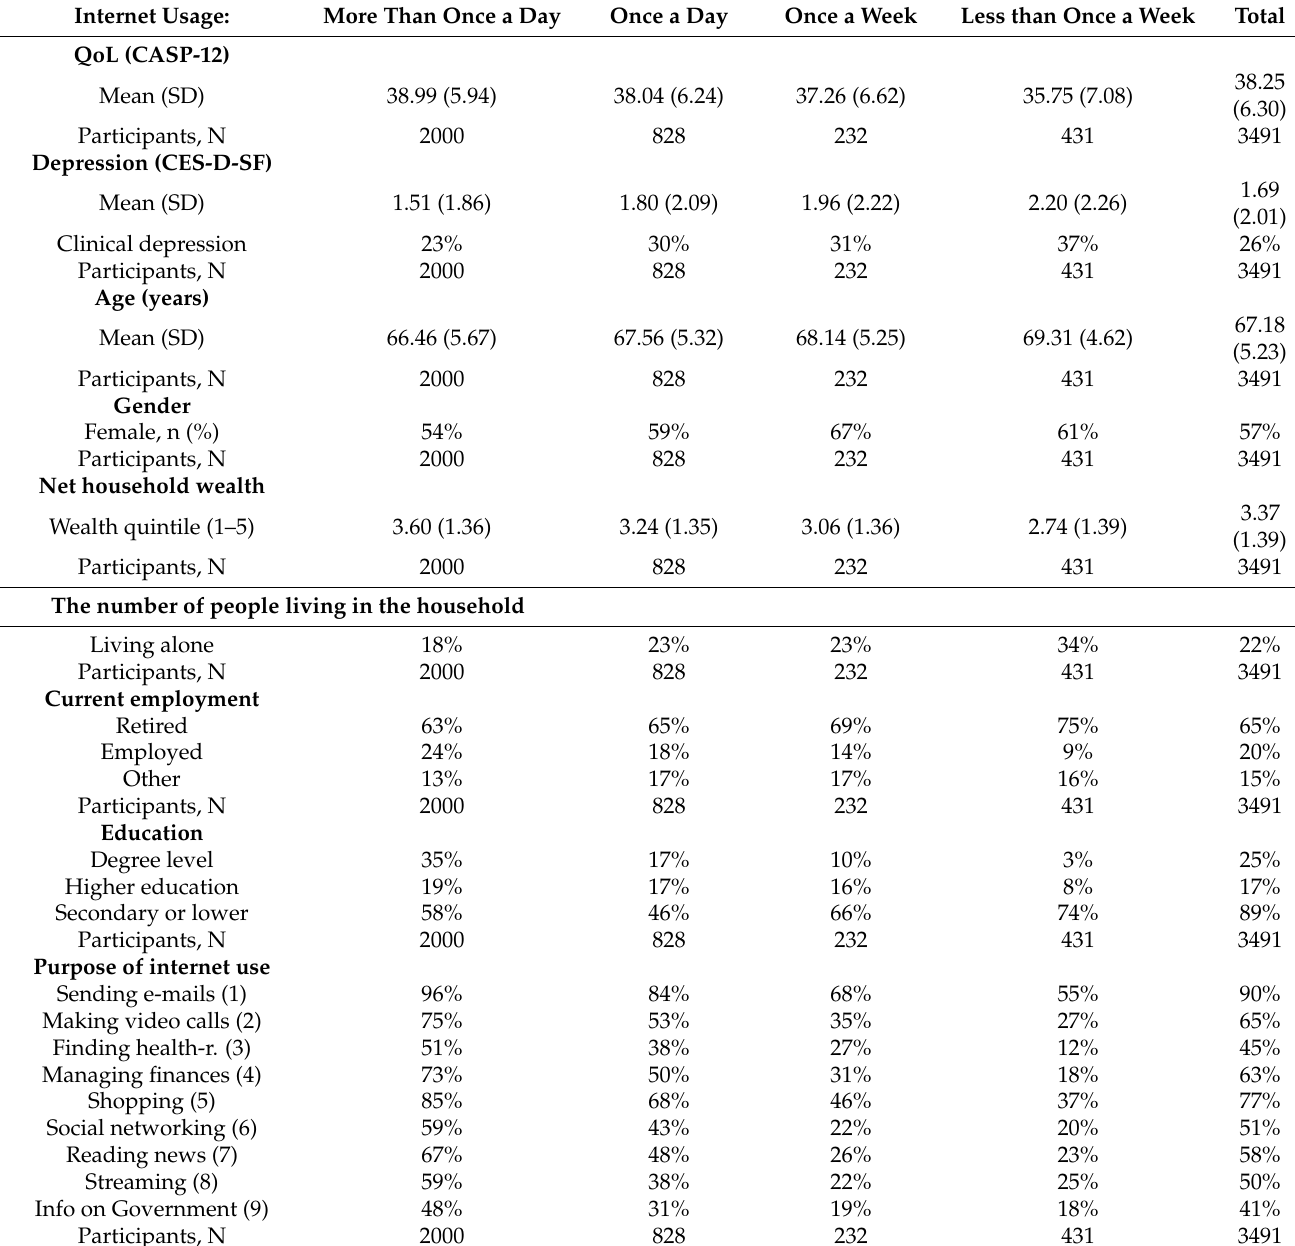
(Figure 1). Pairwise comparisons (with Bonferroni correction) identified a significant difference between Group 1 (more than once a day) and Group 4 (less than once a week), p < 0.001. Similar effects were seen when depression scores were categorised using a cut-off of ≥ 3 on the CES-D-SF (corresponding with a clinical diagnosis of depression): 23% of the most frequent users met this criterion for a depression diagnosis, compared to 29% of the every day users, 31% of the individuals who used the internet once a week, and 37% of the participants who used the internet less than once a week. Table 1. Summary of participant characteristics by frequency of internet use (categories